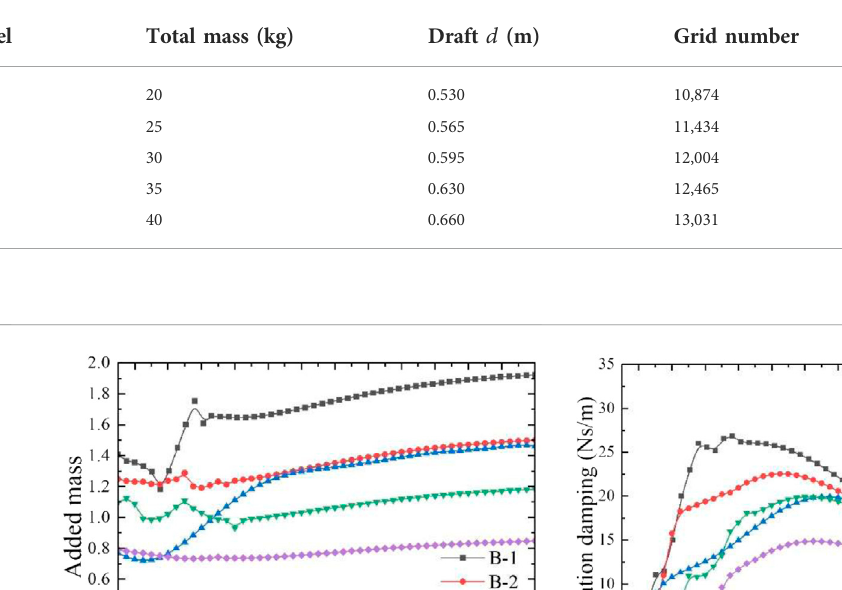
TABLE 3 Model B with different drafts.